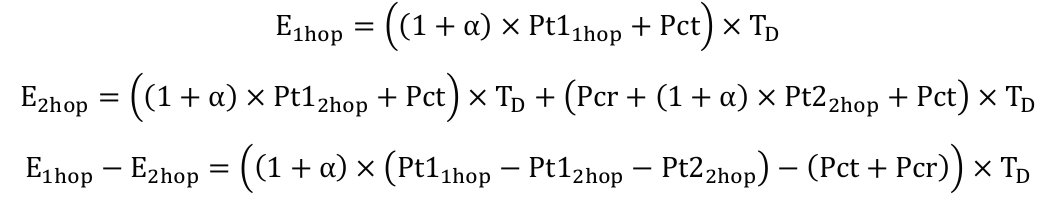
Figure 2. Energy consumption vs . number of hops for different circuitry